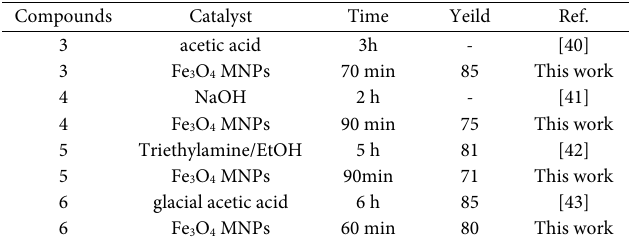
Table 3: Recycling of the Fe 3 O 4 MNPs catalyst.